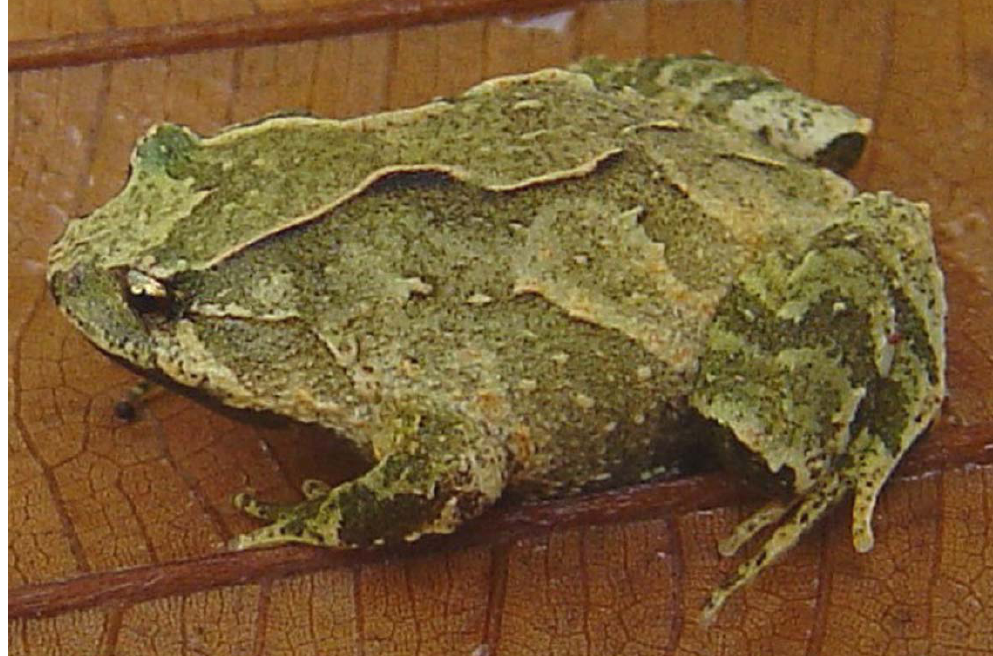
Figure 2. Zachaenus parvulus from Reserva Biológica Poço das Antas , state of Rio de Janeiro, Brazil. Photo